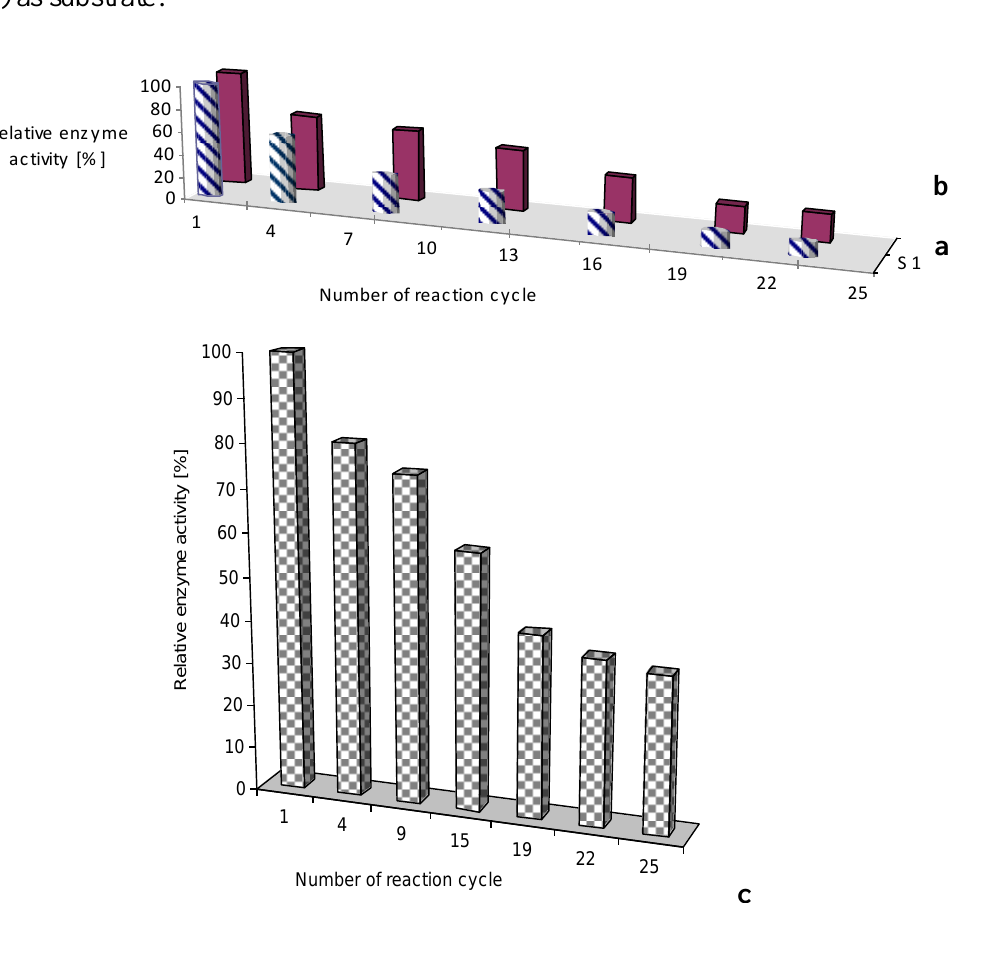
Table 3. Immobilized proteins activity in presence of various phenolic compounds